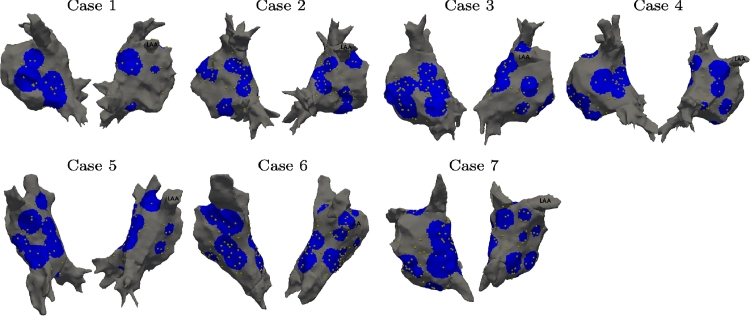
Anatomies for clinical cases 1–7. The gold spheres represent the position of the electrodes. The blue region represents the atrium surface covered by measurements. (For interpretation of the references to colour in this figure legend, the reader is referred to the web version of this article.)